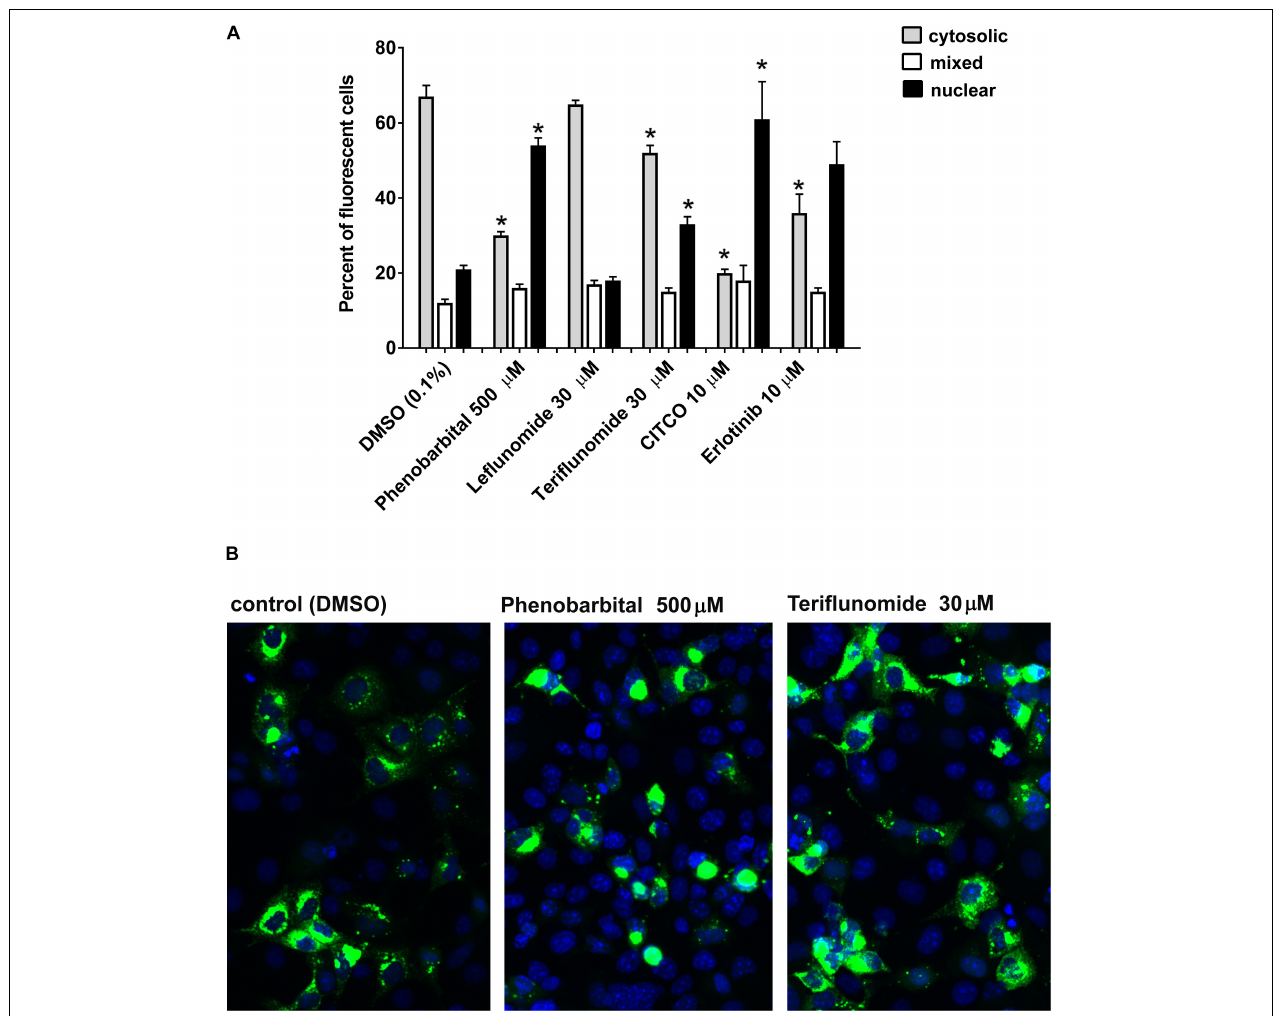
FIGURE 2 | Drug-stimulated cytoplasm-nuclear translocation of hCAR ligand-sensitive mutant (hCAR+Ala) in COS-1 cells. (A) COS-1 were transfected with 100 ng/well of pEFGP-CAR+Ala mutant and exposed to phenobarbital, LEF, TER, CITCO, or EGFR antagonist erlotinib for 24 h. After incubation, the cells were stained by Hoechst 33342. Confocal microscopy was performed, and cells with dominant cytoplasm, nuclear or mixed (nuclear and cytoplasm) fluorescence localization were classified. At least 100 cells were analyzed for each compound and percentage calculated in three independent experiments ( n = 3). (B) TER partly simulates nuclear localization of EGFP-tagged hCAR+Ala, although the majority of fluorescence remains in the cytoplasm after 48 h. Confocal images illustrate representative localization and translocation of EGFP-tagged hCAR+Ala expression after the vehicle control or drug treatment. Magnification 20 × . ∗ P < 0.05 – statistically significant difference compared to nuclear or cytoplasm localization in the control (DMSO-treated) cells (ANOVA with a Dunnett’s post hoc